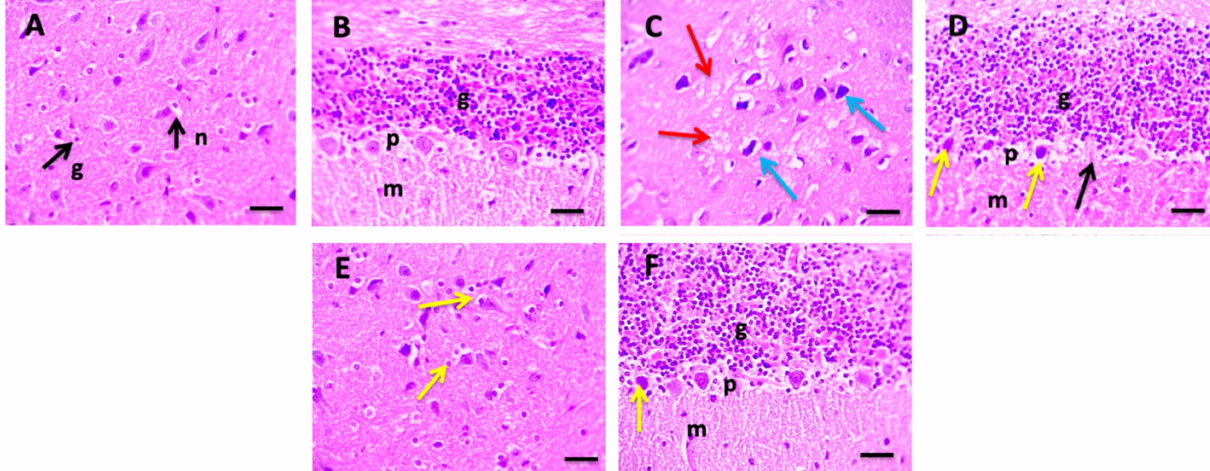
Figure 2. Microscopic pictures of H&E-stained cerebral sections in the normal control (NC) group ( A ) showing normal pyramidal neurons (n) and glial cells (g). Cerebellar sections showing normal grey and white matter in the NC group ( B ). Grey matter showing normal granular (g), Purkinje (p), and molecular (m) layers. Cerebral sections from cisplatin (CP) group ( C ) showing vacuolations (red arrows), marked shrinkage in pyramidal neurons, perineural edema with extensively dark pyknotic nuclei (blue arrows). Cerebellar sections from CP group ( D ) showing deeply stained Purkinje cells with pyknotic nuclei (yellow arrows) and loss of Purkinje nerve fibers (black arrows) (p). Cerebral sections from bone marrow-derived mesenchymal stem cells (BM-MSCs) group ( E ) showing satellitosis (yellow arrows). Cerebellar sections from BM-MSCs group showing decreased damage to Purkinje nerve fibers ( F ). × 400, bar 50 µ